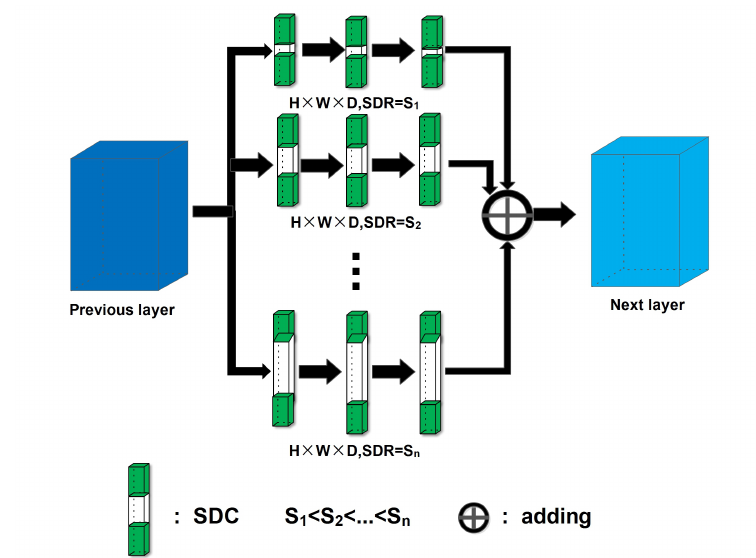
Figure 6. Structure of multiple spectral resolution